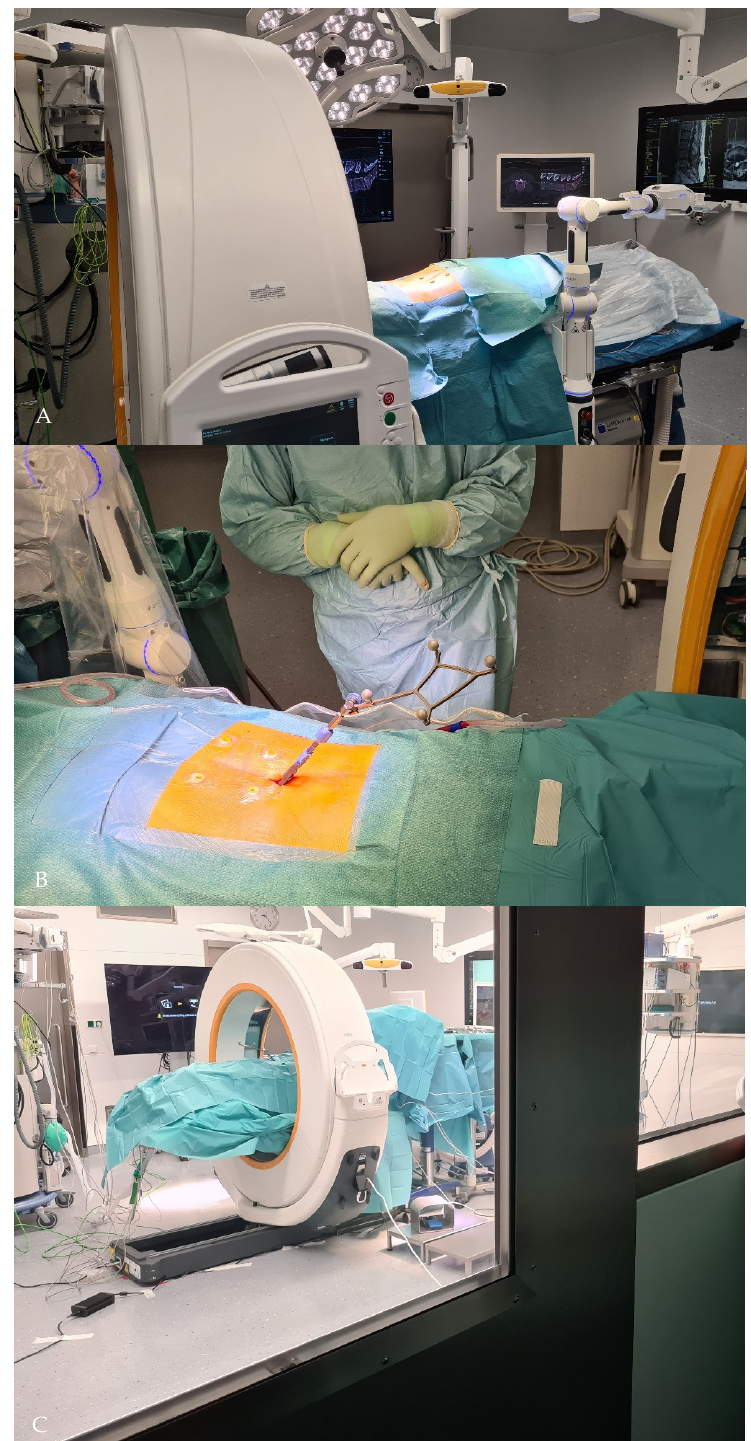
Figure 2. Perioperative setting. ( A ). Cirq ® is attached on the left side of the operating table. ( B ). Sur- gical field is prepped and draped. Four fiducials are attached to the skin prior for accuracy check. Reference array is in this case of percutaneous, minimally invasive pedicle screw implantation, is attached to a spinous process proximal to the surgical field via separate skin incision. ( C ). View of the patient while performing initial registration iCT